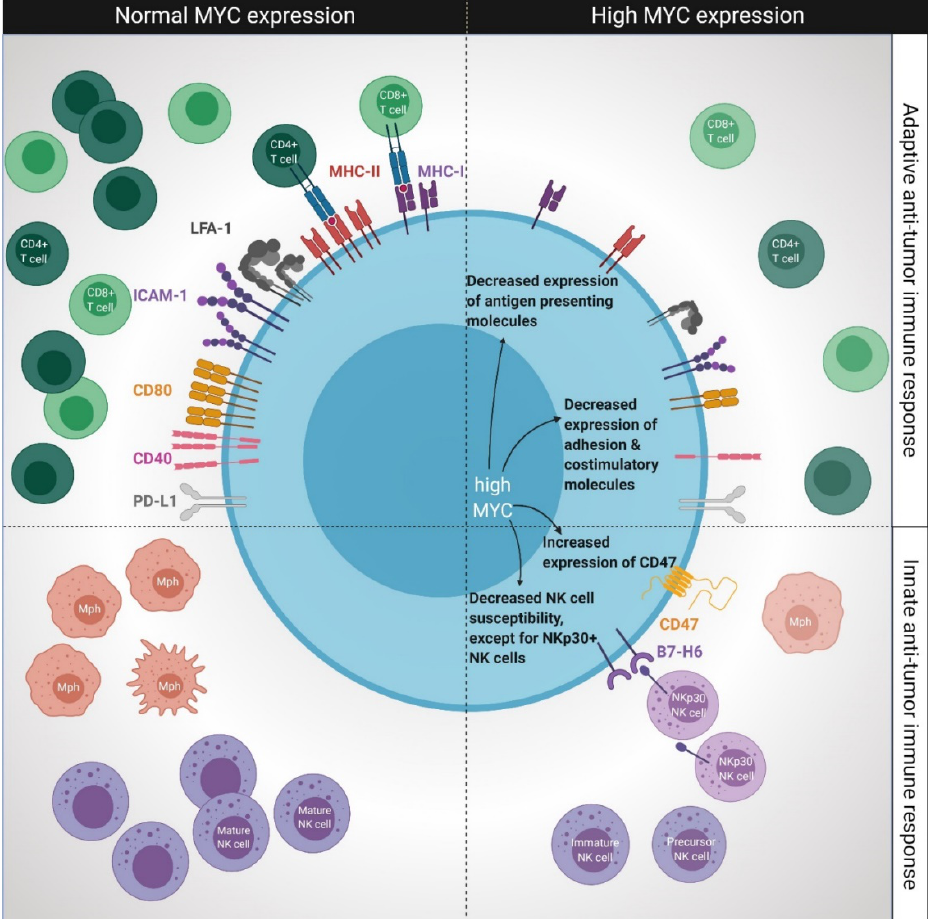
Figure 1. MYC overexpression is associated with reduced T cell-mediated anti-tumor immune responses and impaired innate anti-tumor immune responses by macrophages and NK cells, but not NK cells with the NKp30 receptor. Top left: simplified summary of adaptive immune responses towards malignant cells with normal MYC expression. Top right: MYC overexpression decreases expression of MHC class I and class II molecules, adhesion and costimulatory molecules. MYC overexpression is associated with reduced cytotoxic T cell responses. Di ff erent outcomes on the correlation between MYC overexpression and expression of immune checkpoint programmed death-ligand 1 (PD-L1) have been described. Bottom left: simplified summary of innate immune responses towards malignant cells with normal MYC expression. Bottom right: MYC overexpression reduces NK cell amounts, but not cytotoxicity induced via NKp30 NK cells. MYC overexpression induces expression of immune checkpoint CD47, preventing macrophage (Mph)-induced